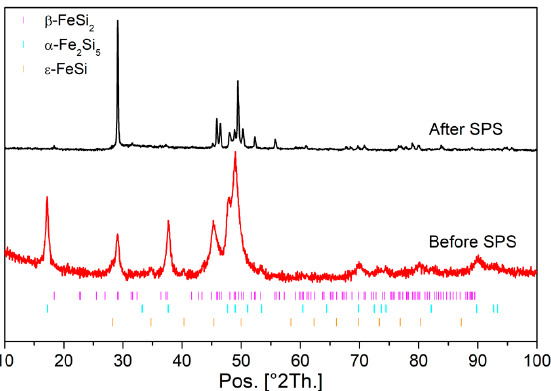
Figure 4. X-ray Diffraction pattern of β -Fe 0.95 Co 0.05 Si 2 sample S4 obtained before and after the sintering of Fe-Co-Si powder milled for 10 h.